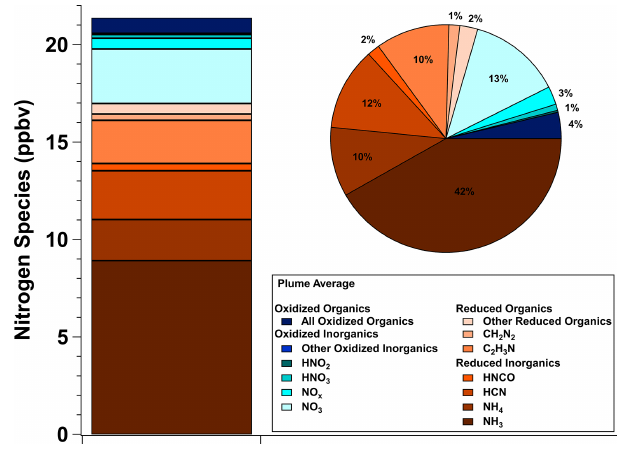
Figure 4. Background-subtracted average screen 1 in-plume mix- ing ratios of measured gas- and particle-phase N-containing species (N r ) and their fractional contribution to the total summed N r species. The N r species are grouped into categories of reduced inor- ganics, reduced organics, oxidized inorganics, and oxidized organ- ics with reduced species in shades of red and oxidized species in shades of